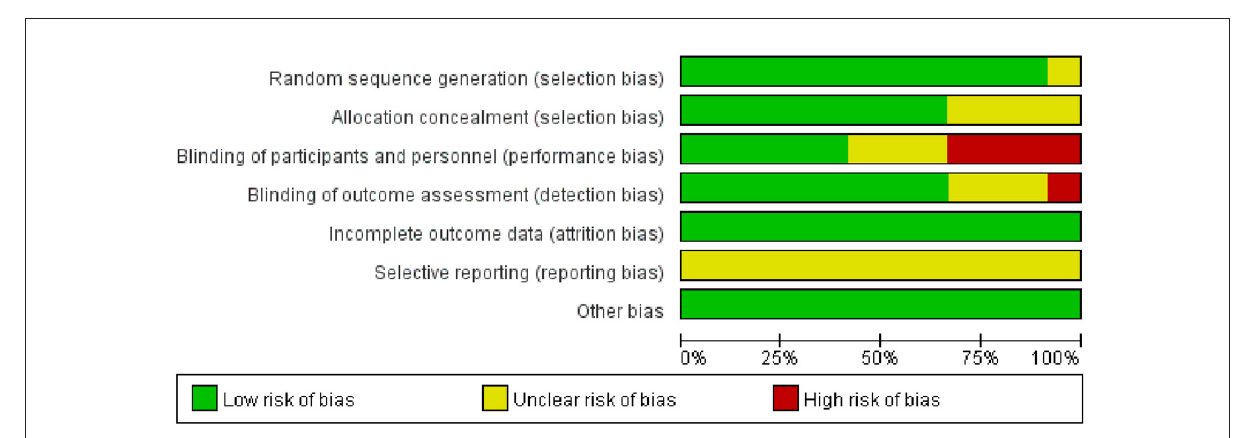
FIGURE2 Percentage of biased items